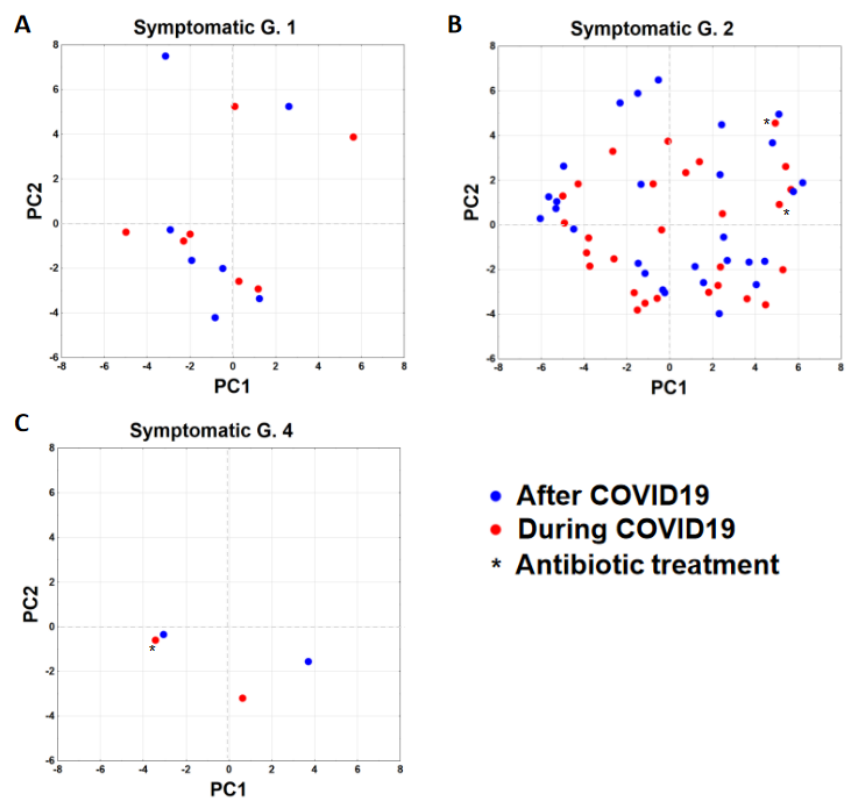
Figure 3. Principal component analysis of gut microbiota composition of subjects. Principal com- ponent analysis of the bacterial composition data. Subjects are divided into symptomatic group 1 (panel A ), 2 (panel B ) and 4 (panel C ) and plotted according to the two principle component with the highest explanation of the variance (PC1: 14.5% and PC2: 10.5% respectively). Red dots representing samples taken During COVID19 infection, blue dots showing samples taken after infection. Asterisk marks individuals who was treated with